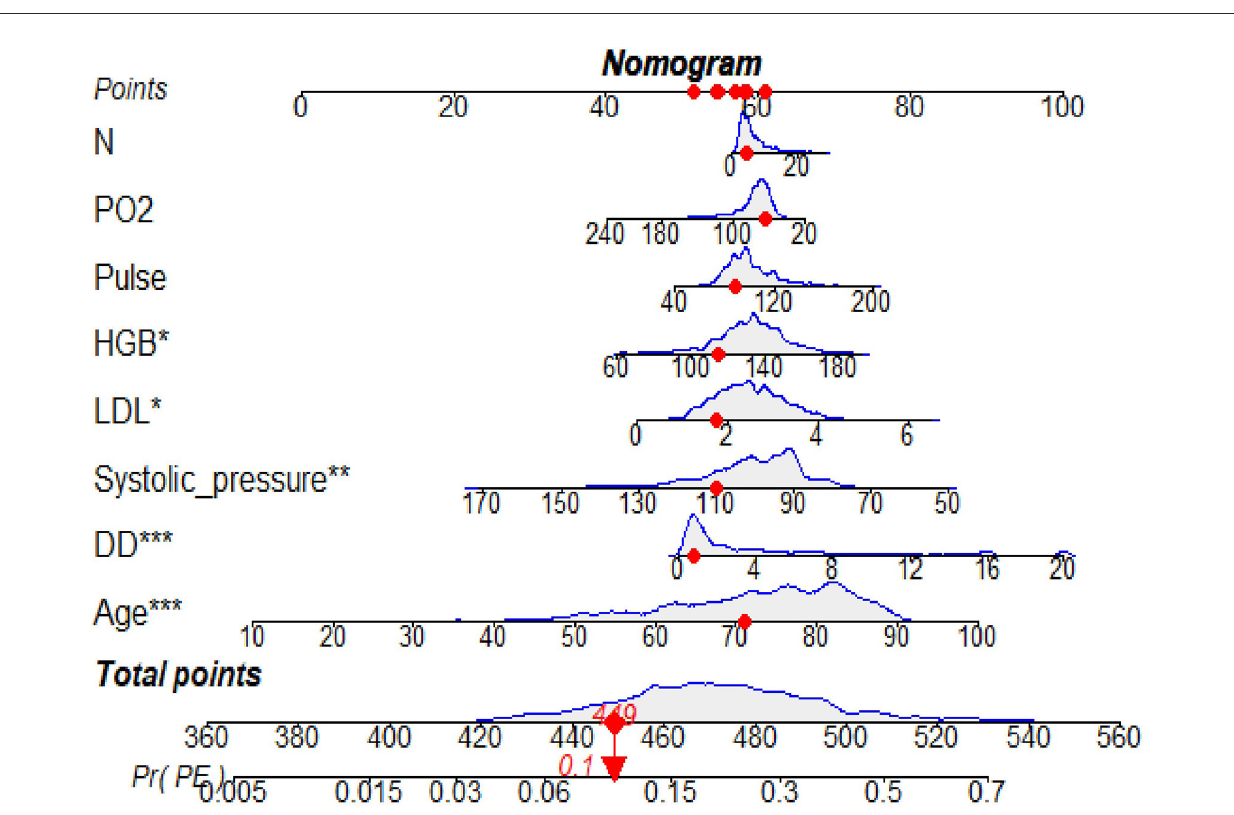
FIGURE3 A nomogram based on the combination of eight indicators was developed using logistic regression analysis. If the neurology department patient had a total score of 449 points, this corresponded to an ∼ 10% risk of PE and then the probability of the PE was 0.1 (red numbers). HGB, hemoglobin; N , neutrophil count; LDL, low-density lipoprotein; DD, D-dimer; PO2, oxygen partial pressure (PO 2 ). * p < 0.05, ** p < 0.01, *** p <